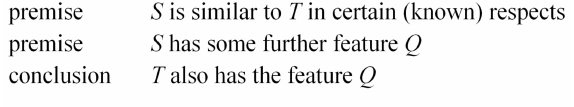
Figure 1. The general form of an analogical argument (Bartha 2016: